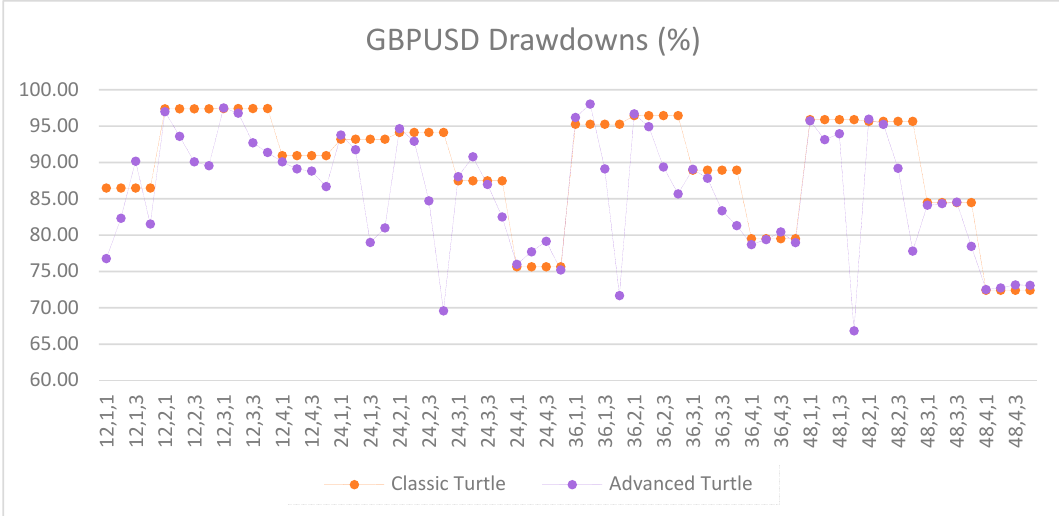
Figure A5. Net profits of GBPUSD between the classic and the advanced Turtle systems for every combination of N, X, Y for the fast parameters (20, 40).